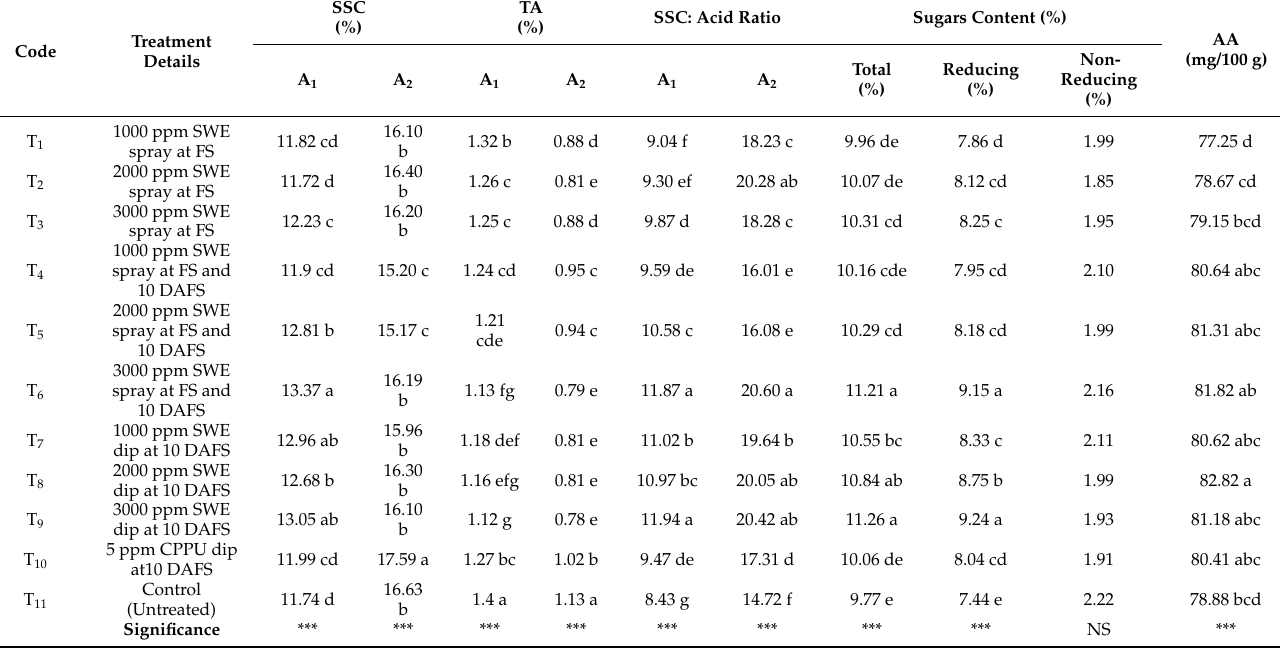
Table 3. Effect of seaweed extract on chemical characteristics of kiwifruit.